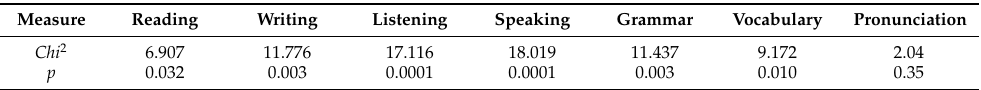
Table 3. Effect of SA on self-reported proficiency in four skills and three domains of French (Friedman tests).